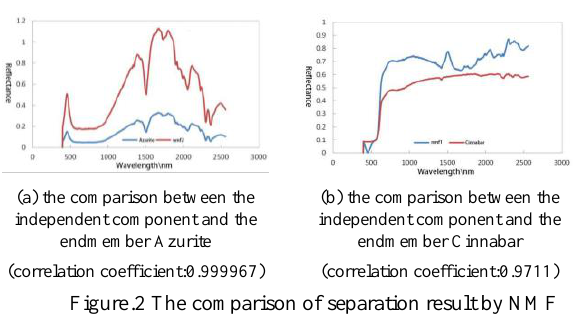
Figure.1 The comparison of separation result by FastICA